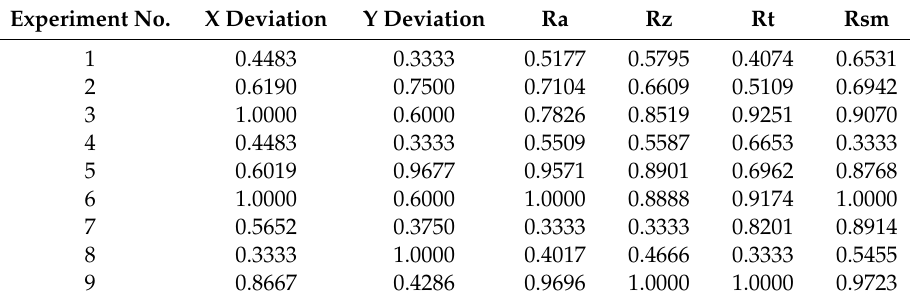
Table 11. Grey relational coe ffi cient results.